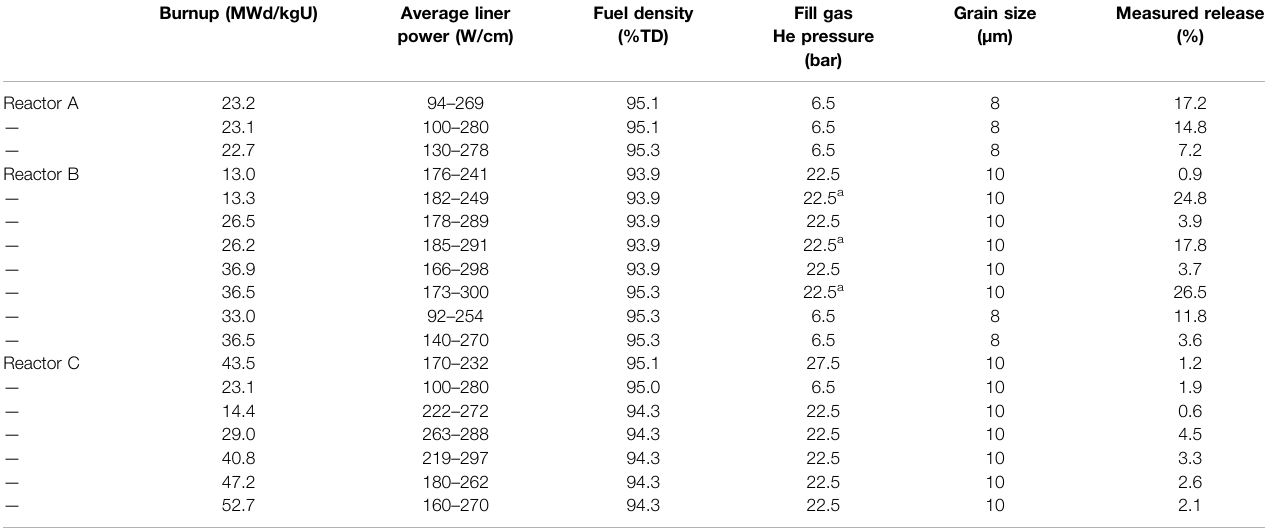
TABLE 6 | Fission gas release data obtained from LWR fuels subjected to no power ramps during irradiation (Koo et al., 2000). Burnup (MWd/kgU)